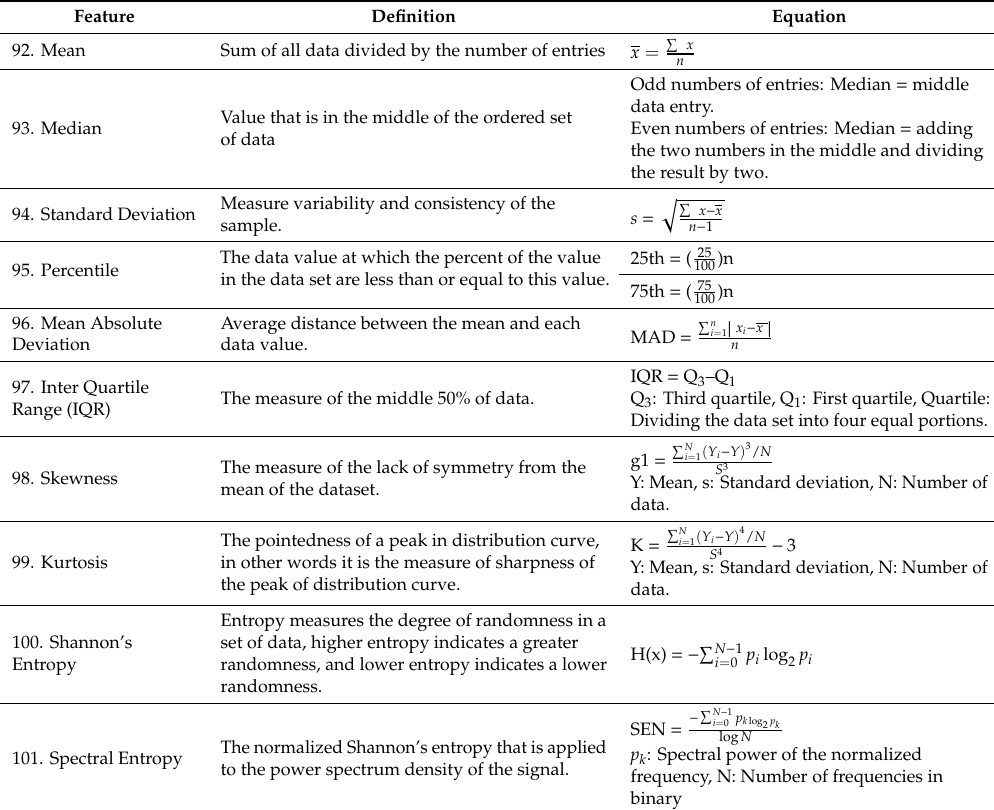
Table 7. Ten statistical